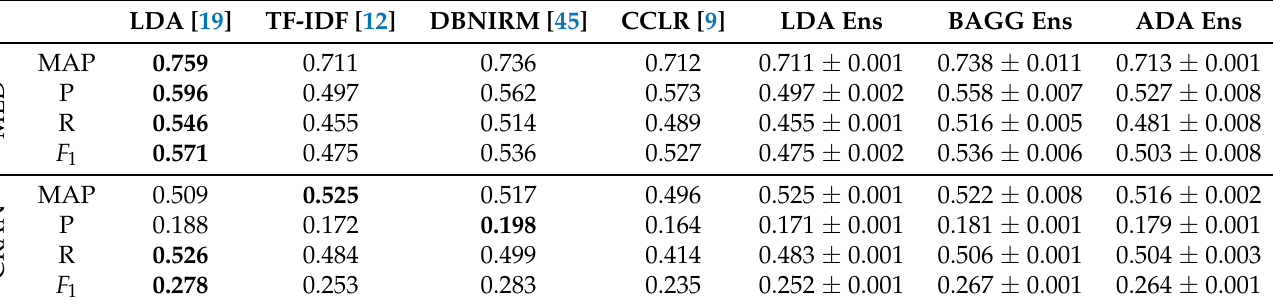
Table 5. Results reported using @20